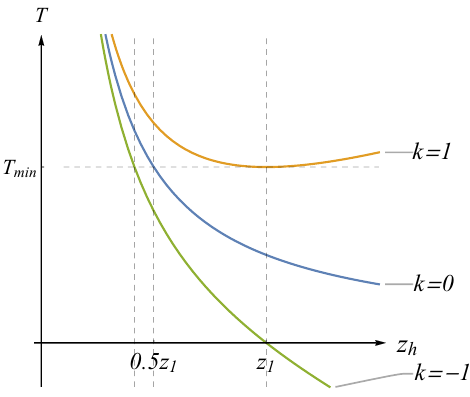
Figure 7 . The sketch of T ( z h ) with different k . The T min is the lower bound of the f 0 . So the derivative of G ( z ) with respect to k ext